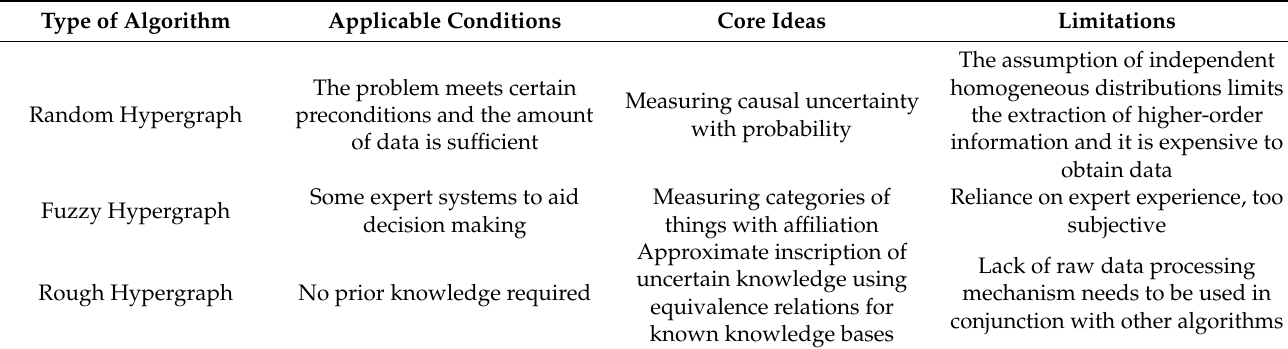
Table 5. Comparative analysis of uncertainty hypergraph